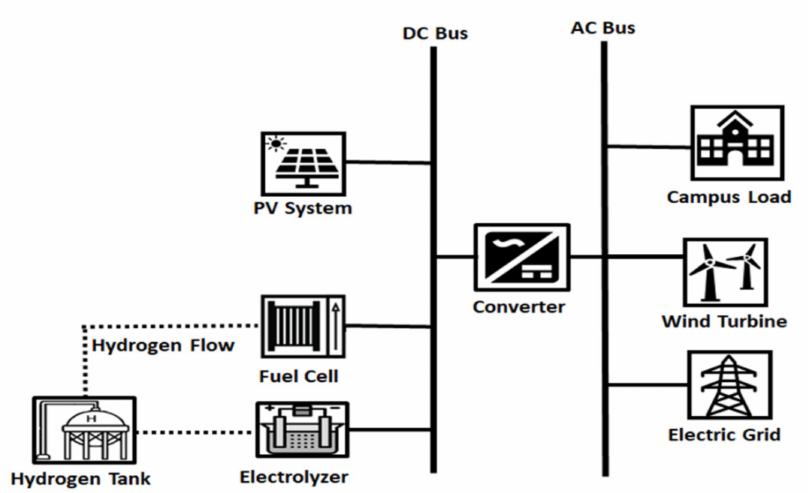
Figure 2. Hybrid renewable energy system (HRES) at the Chikushi campus of Kyushu